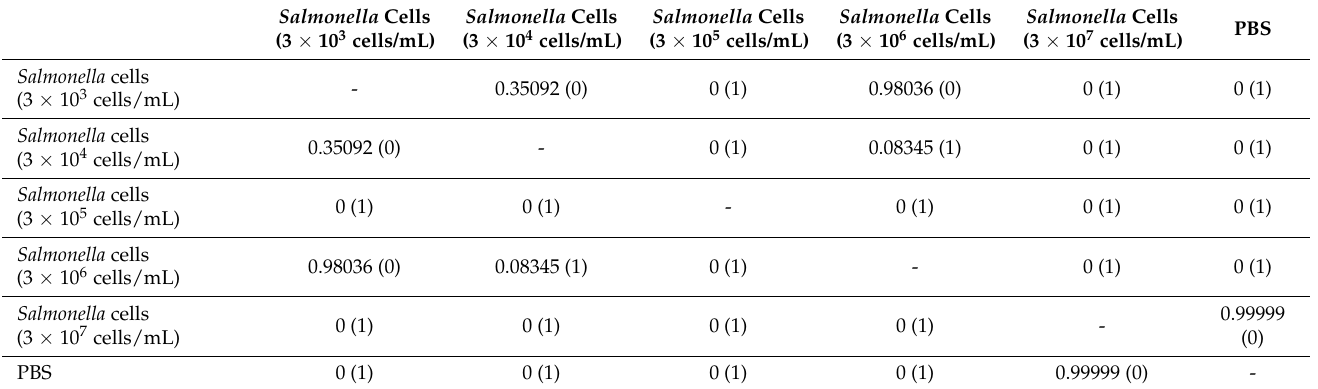
Table 4. Optimization of cells in different concentration for sensor application. p -value for each pair of data analyzed using one-way ANOVA. The significance value (0, 1) provided in parenthesis beside the p -value denotes the significance of each pair of data. The significance value 1 indicates that the data pairs are significantly different ( p -value lesser than 0.05). The significance value 0 depicts that the data pairs are not significantly different ( p -value greater than 0.05).